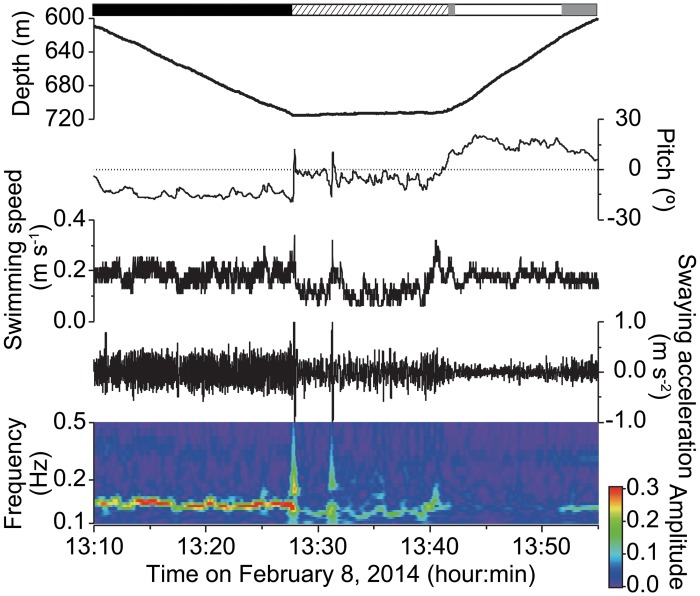
Swimming performance during a vertical movement.Time-series showing depth, pitch, swimming speed and swaying acceleration caused by tailbeat, and wavelet spectrogram of the swaying acceleration during a 45-minute vertical movement by a 440-cm sixgill shark. Negative pitch values indicate the shark was oriented head-downward. Warmer colours in the spectrogram represent stronger signals, whereas cooler colours represent weaker signals. From 13:42 to 13:52, a lack of strong signal in the spectrogram indicates the shark was gliding uphill. The bars above the graph show descent (black), horizontal swimming (shaded), and ascent with tailbeat (gray) and gliding (white). Periodical fluctuations in acceleration were stronger during descent than during ascent (i.e. tailbeat effort was greater during descent than ascent), and gliding was seen only during ascent.